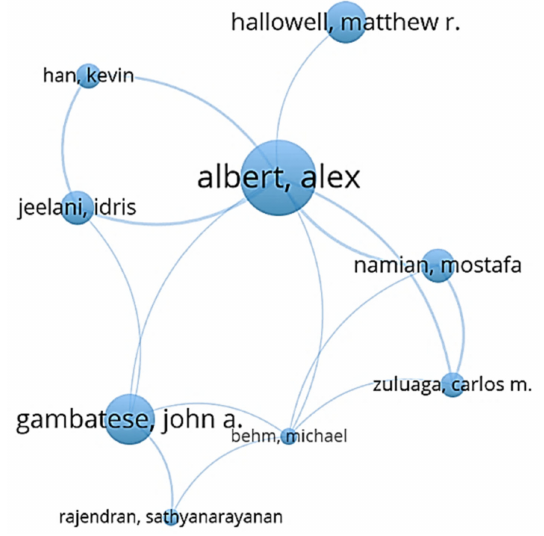
Figure 4. Co-authorship network for cluster